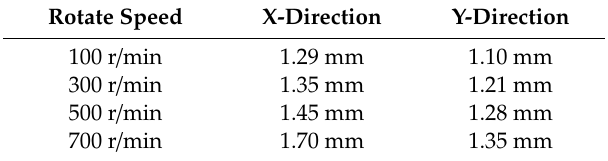
Table 9. Lateral displacement of BHA under di ff erent rotate speeds in experiment.